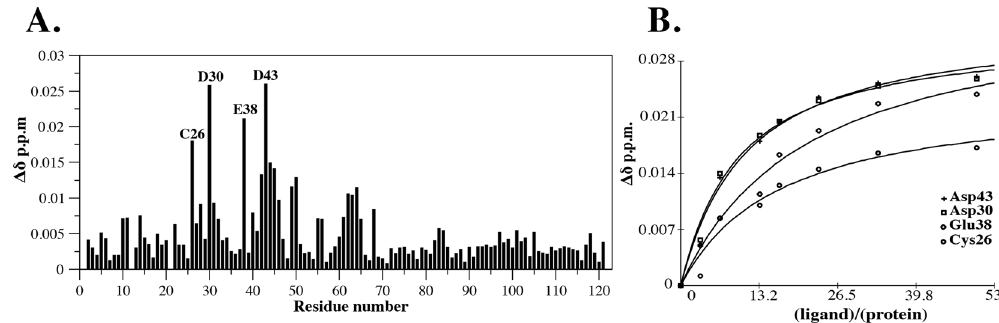
Figure 5. ( A ) Plot of the change in average 1 HN and 15 N chemical shifts following titration of 15 N-RXFP1 (1–72) P4F with 50 equivalents of truncated relaxin. ( B ) Single-site saturation binding curves (K d = 330 ± 10 μ M) for the resonances that show the largest chemical shift changes and remained resolved throughout the